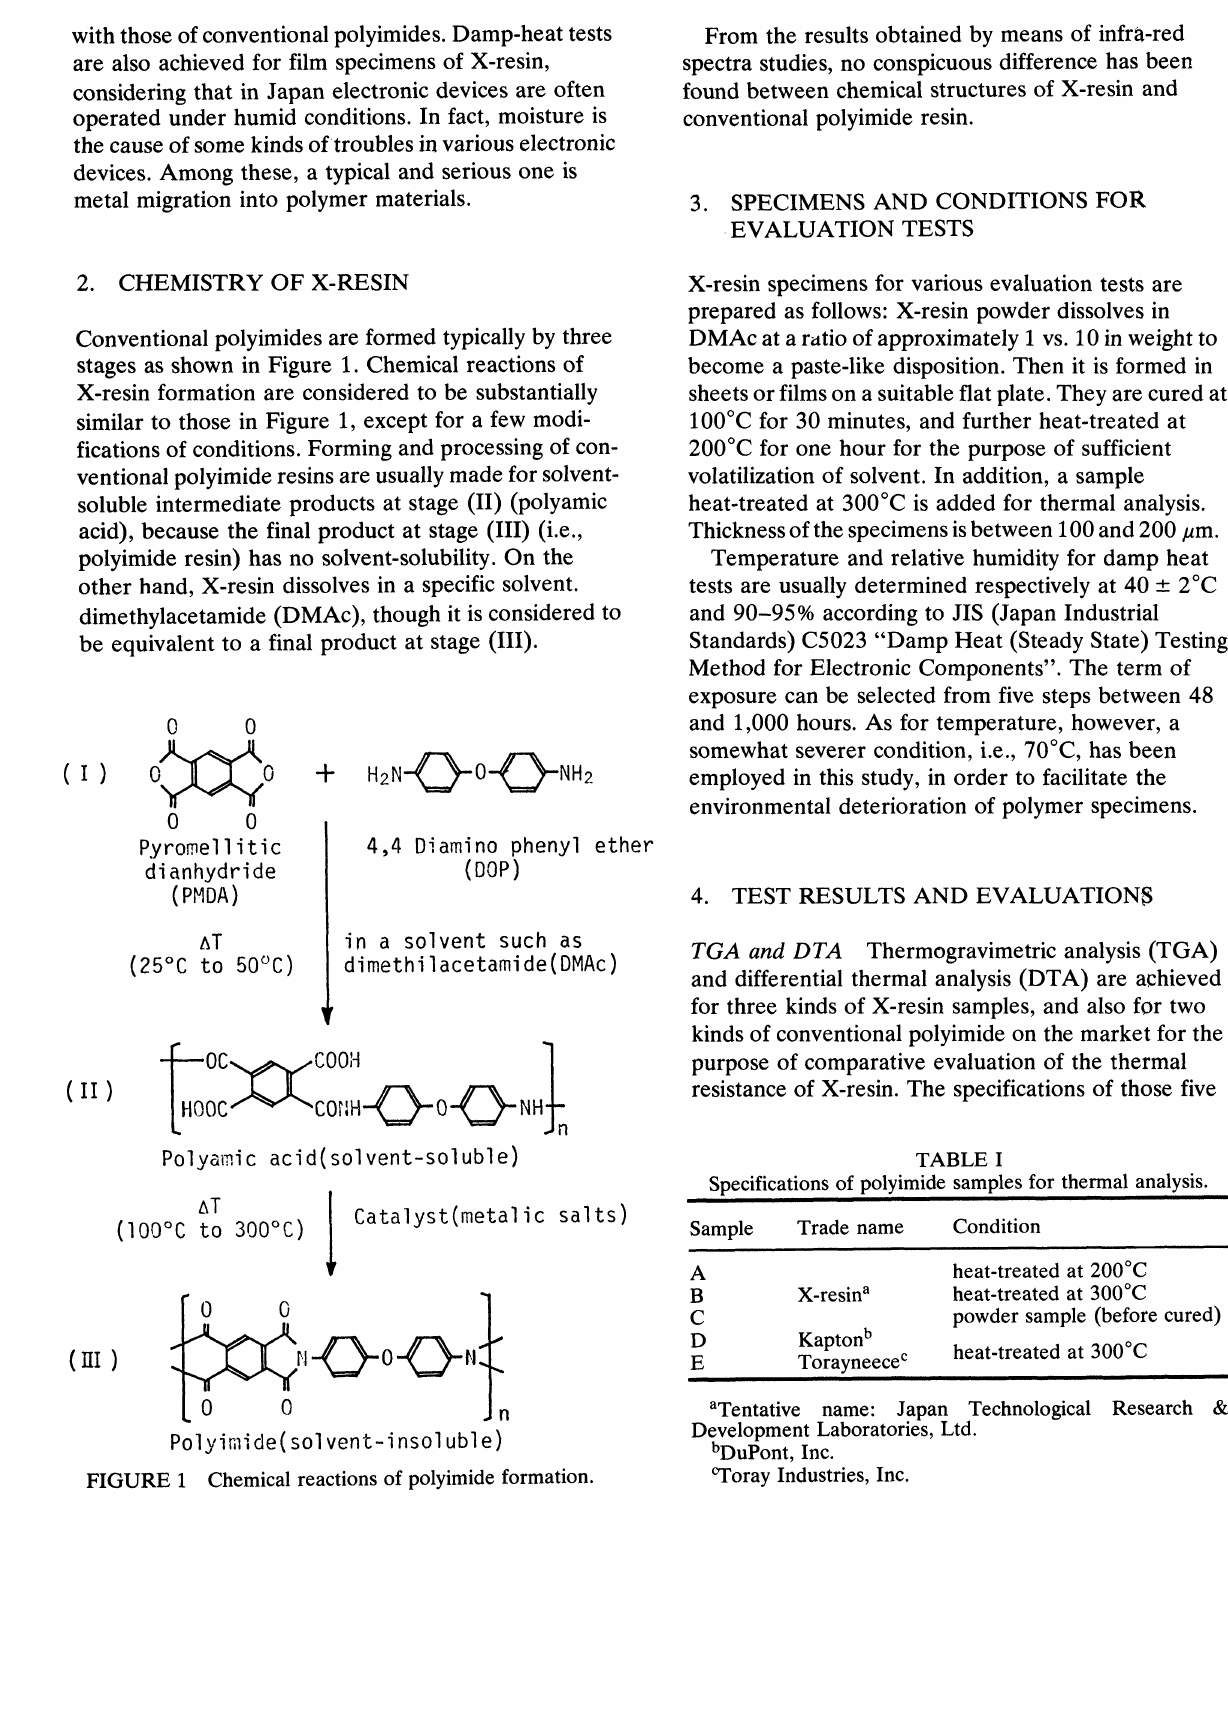
Chemical reactions of polyimide formation.